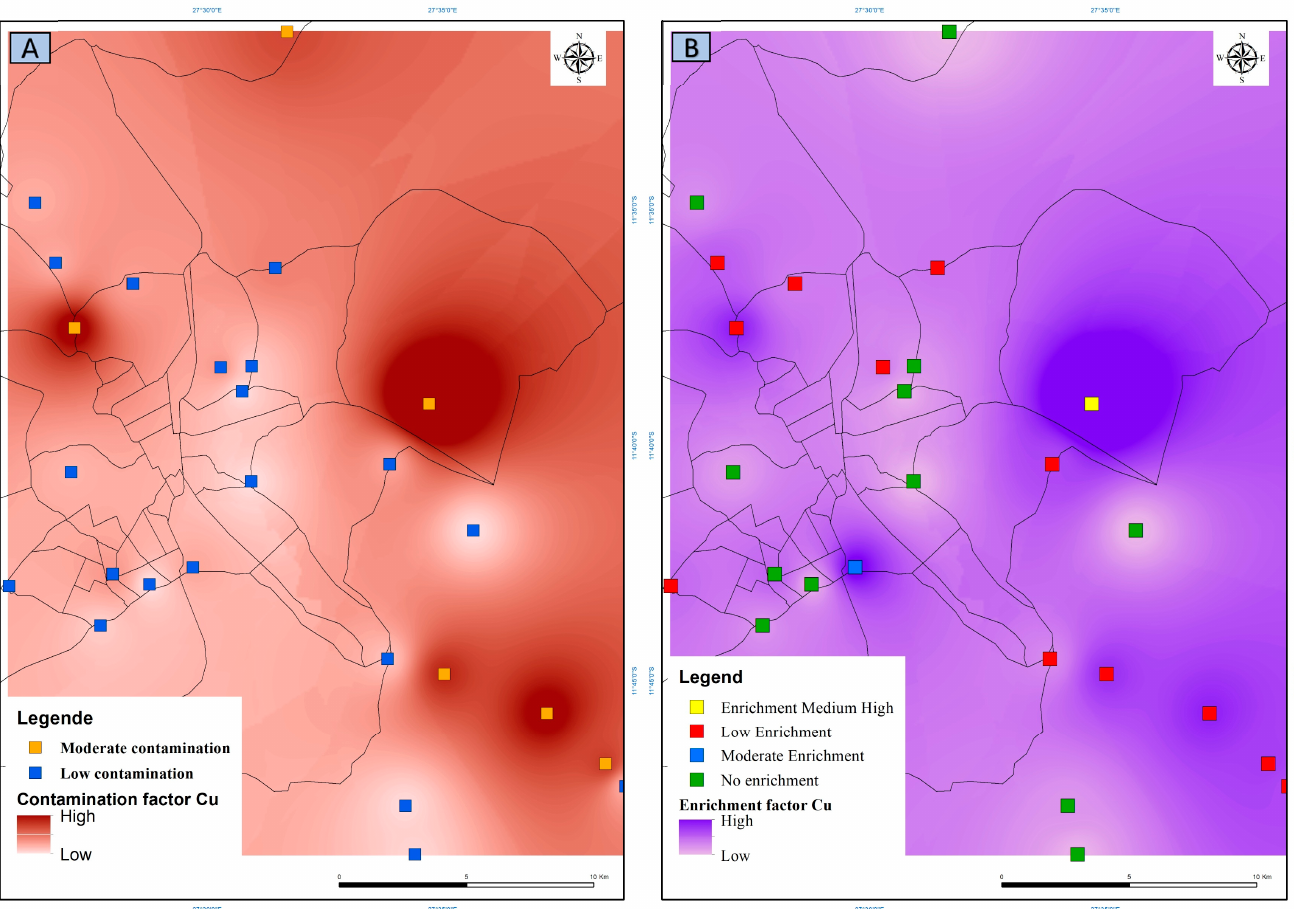
Figure 5. Spatial distribution of metals (Cu) in the market garden soils according to their contamina- tion factor ( A ) and enrichment factor ( B